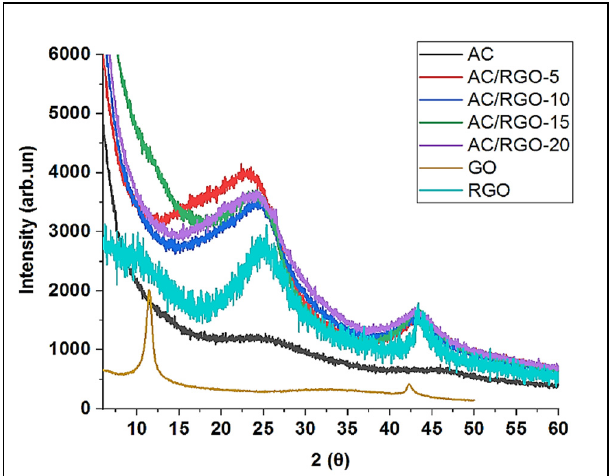
Figure 2. XRD patterns of AC, GO, RGO, and AC/RGO-x (where x = 5, 10, 15, and 20 wt% RGO) .